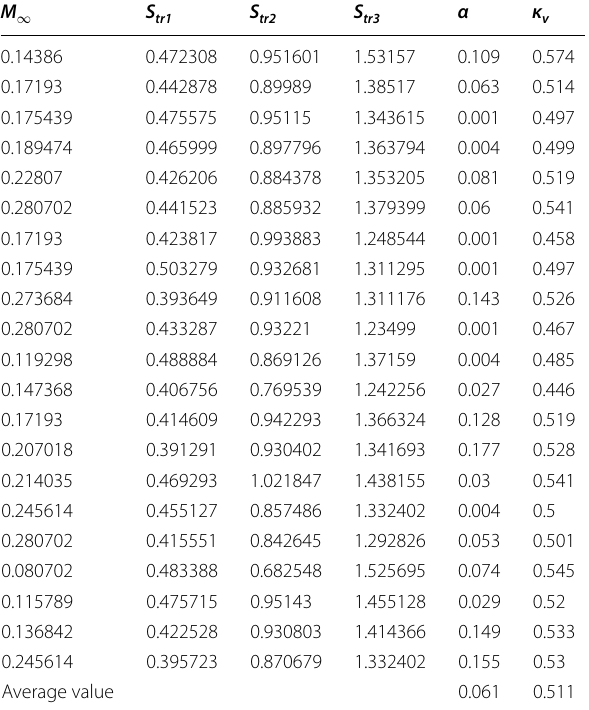
Table 2 Least-squares fitting values of empirical coefficients